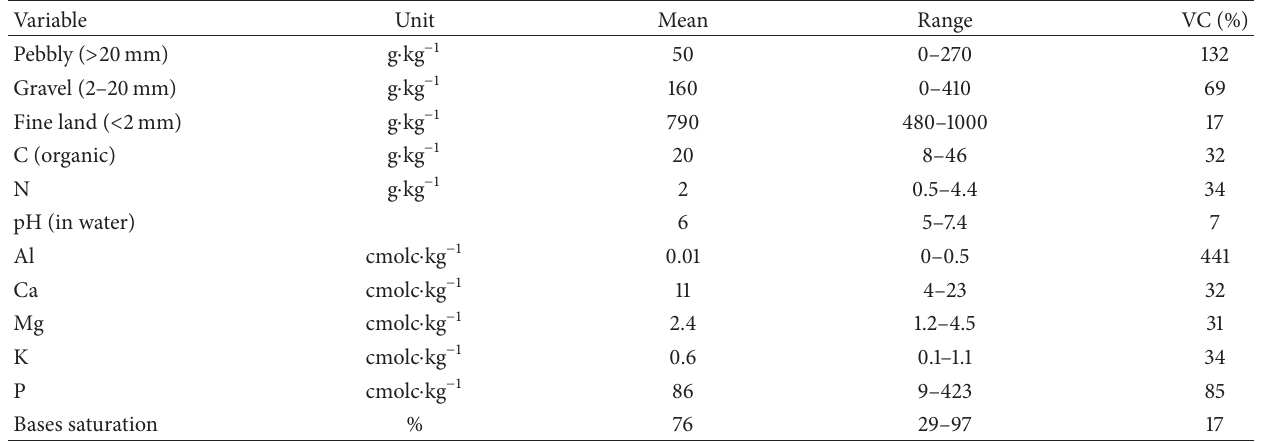
Table 3: Statistics for variables related to the 108 soil samples (Ap